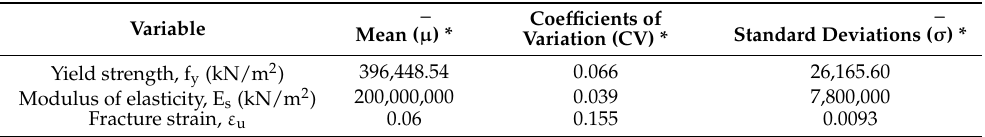
Table 5. Mean values and coefficients of variation of the variables used for probabilistic sampling with the Monte Carlo method.